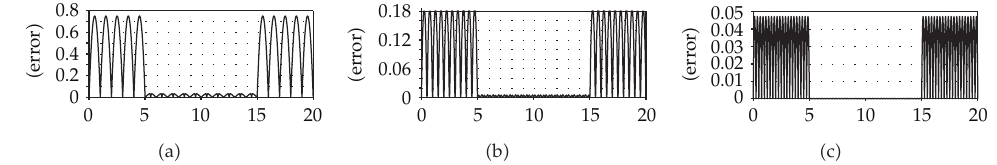
Figure 6: Errors of the hybrid method along y (cid:8) 5 of Figure 3 (cid:2) b (cid:3) . (cid:2) a (cid:3) h (cid:8) 1, (cid:2) b (cid:3) h (cid:8) 0 . 5, and (cid:2) c (cid:3) h (cid:8) 0 . 25. The values of y -axis are absolute errors which decrease according to the size of h